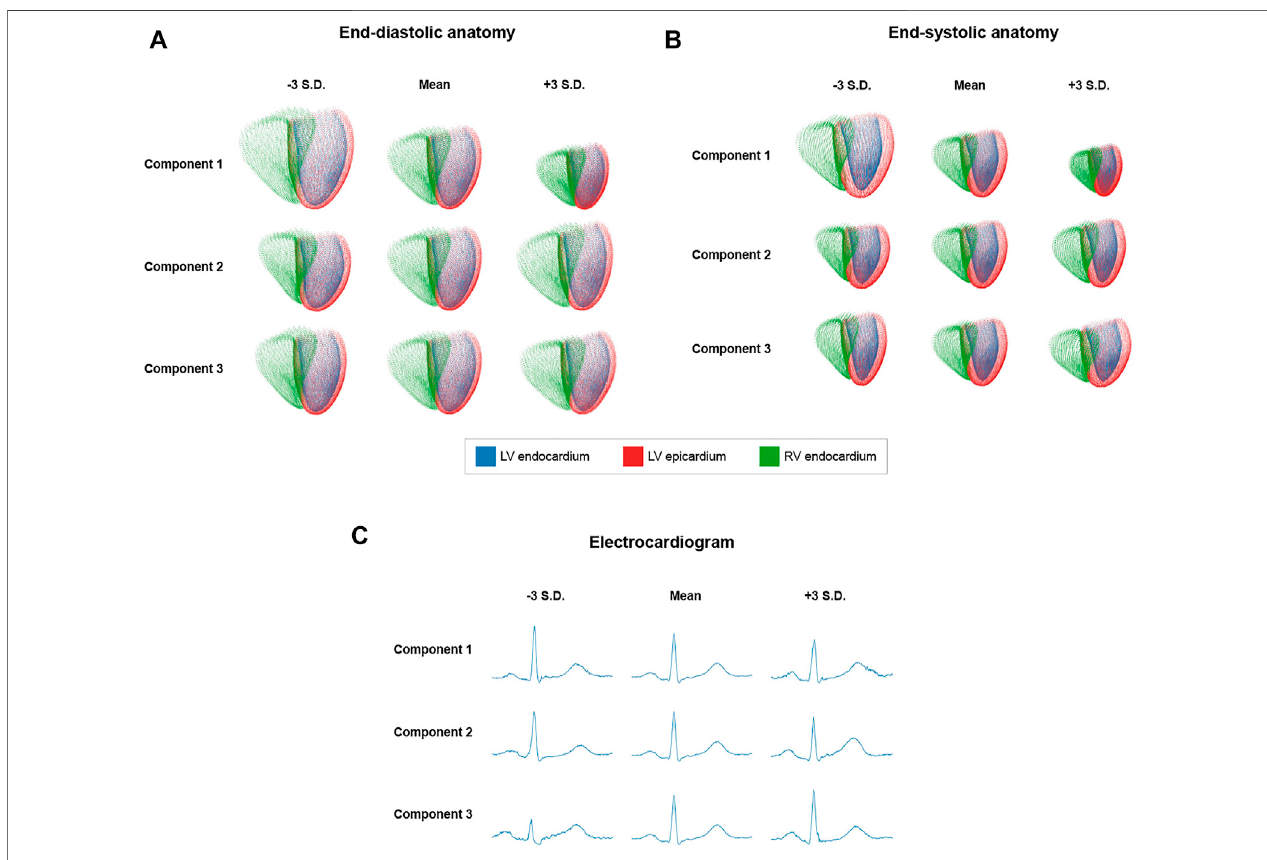
FIGURE 5 | Effects of varying different latent space components by -3 standard deviations (S.D.) and +3 S.D. from their mean values on the generated ED (A) , ES (B) , and ECG (C) outputs.